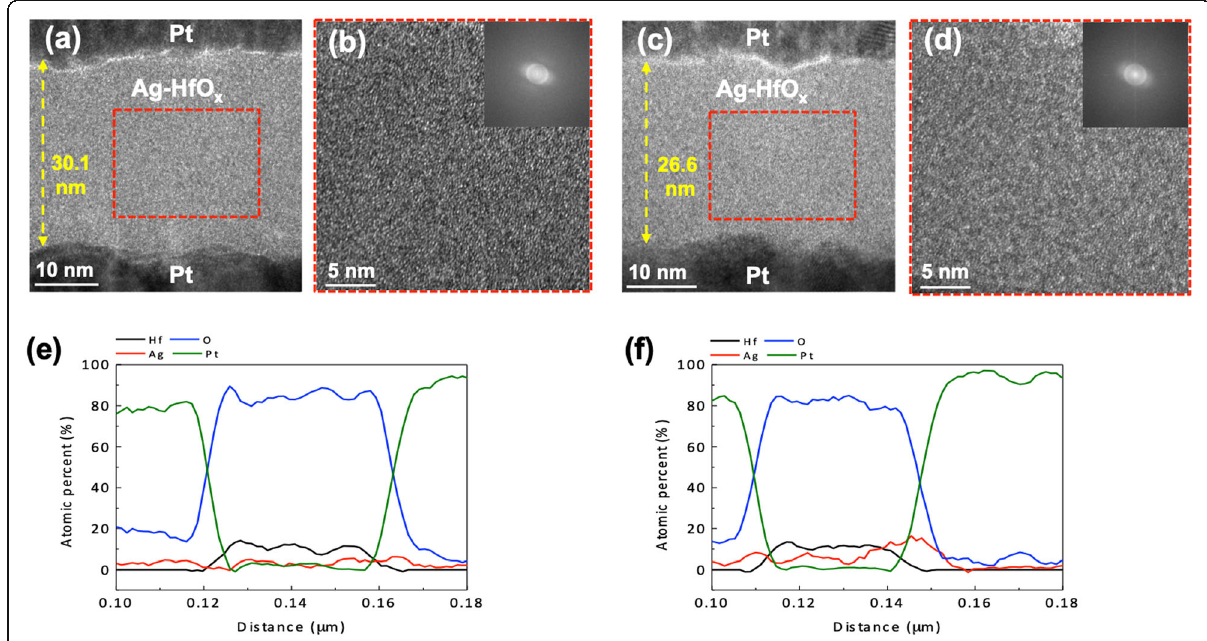
Fig. 4 Microstructural and compositional analysis. a TEM cross-sectional image of D2. b Enlarged TEM image of D2. The inset is the corresponding FFT image. c TEM cross-sectional image of D3. d Enlarged TEM image of D3. The inset is the corresponding FFT image. EDS elemental line profiles of e D2 and f